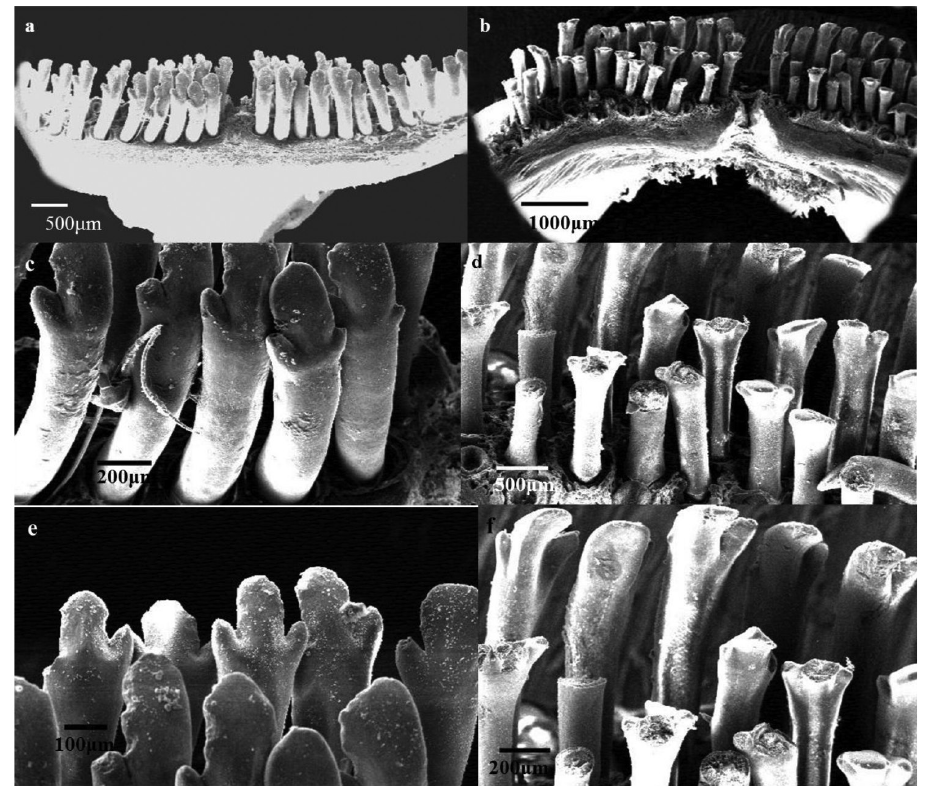
Figure 8. SEM photos of Jaws teeth of I. hormuzensis ; a, c, e upper jaw b, d, f lower jaw.